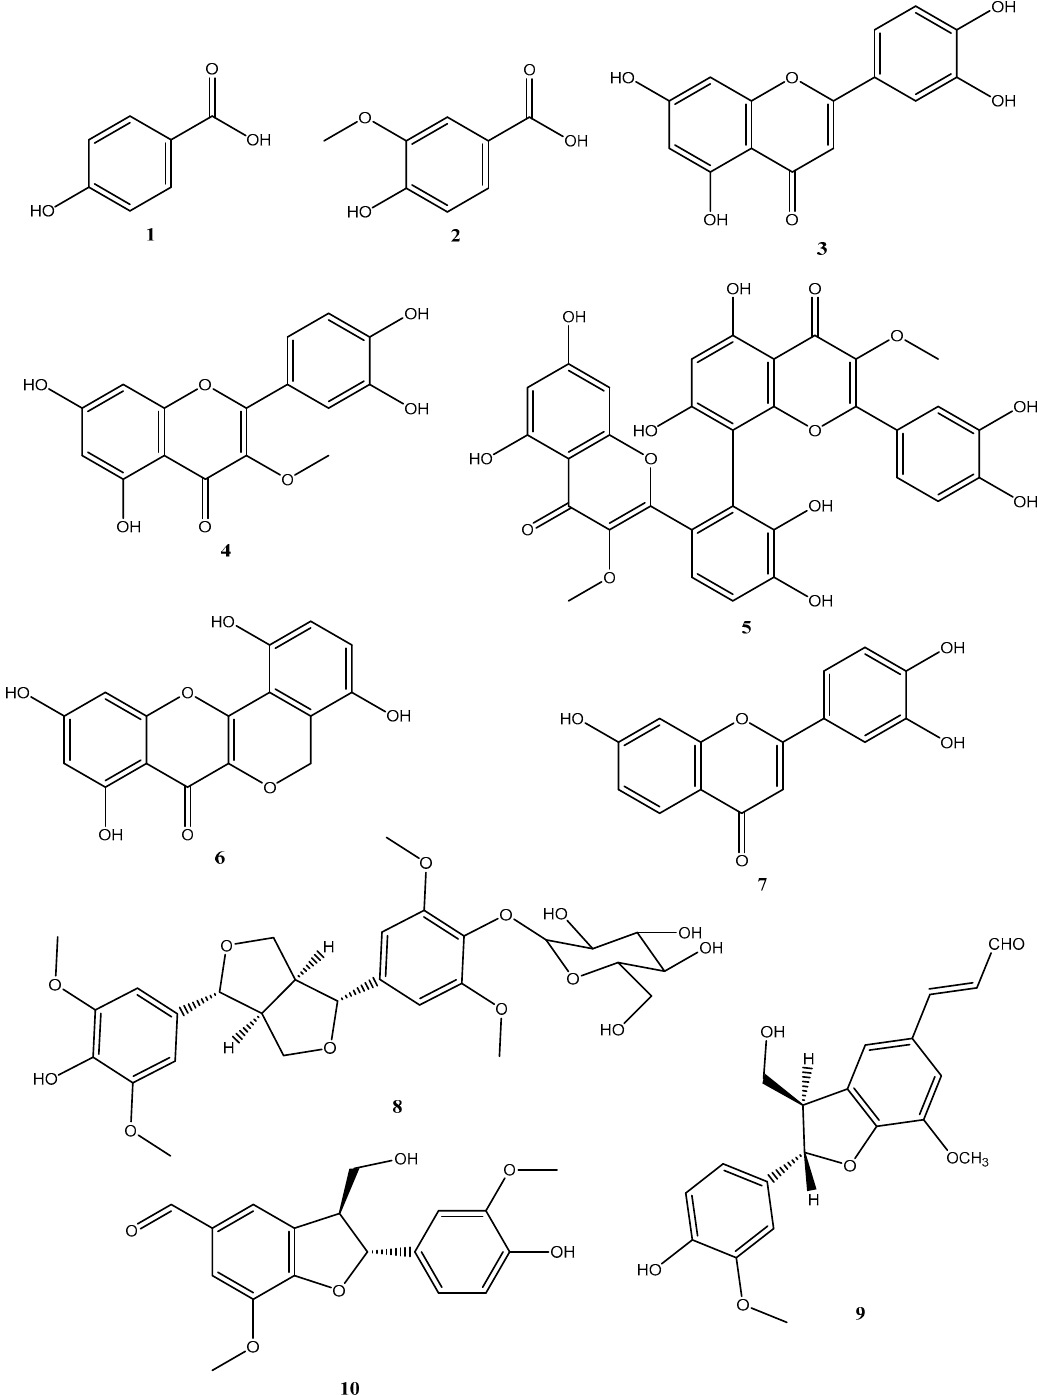
Figure 1. The isolated phenolic acids ( 1 , 2 ), flavonoids ( 3 – 7 ) and lignans ( 8 – 10 ) from the stem bark of Strychnos aff. darienensis